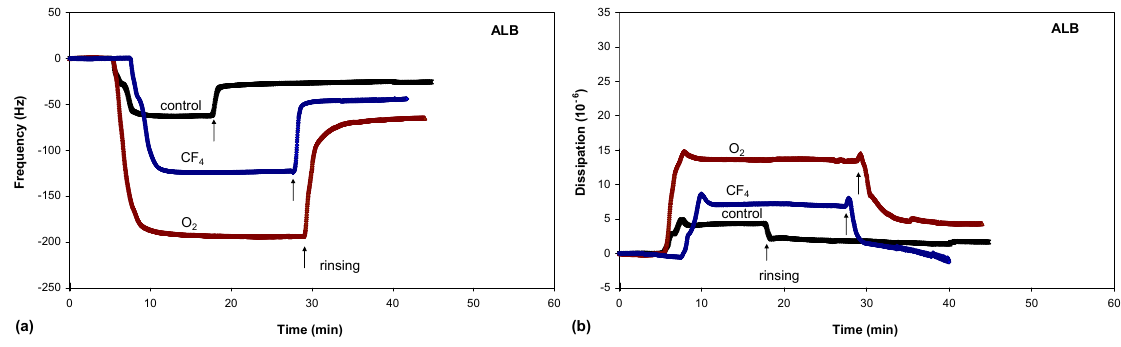
untreated and plasma-treated PET substrates.